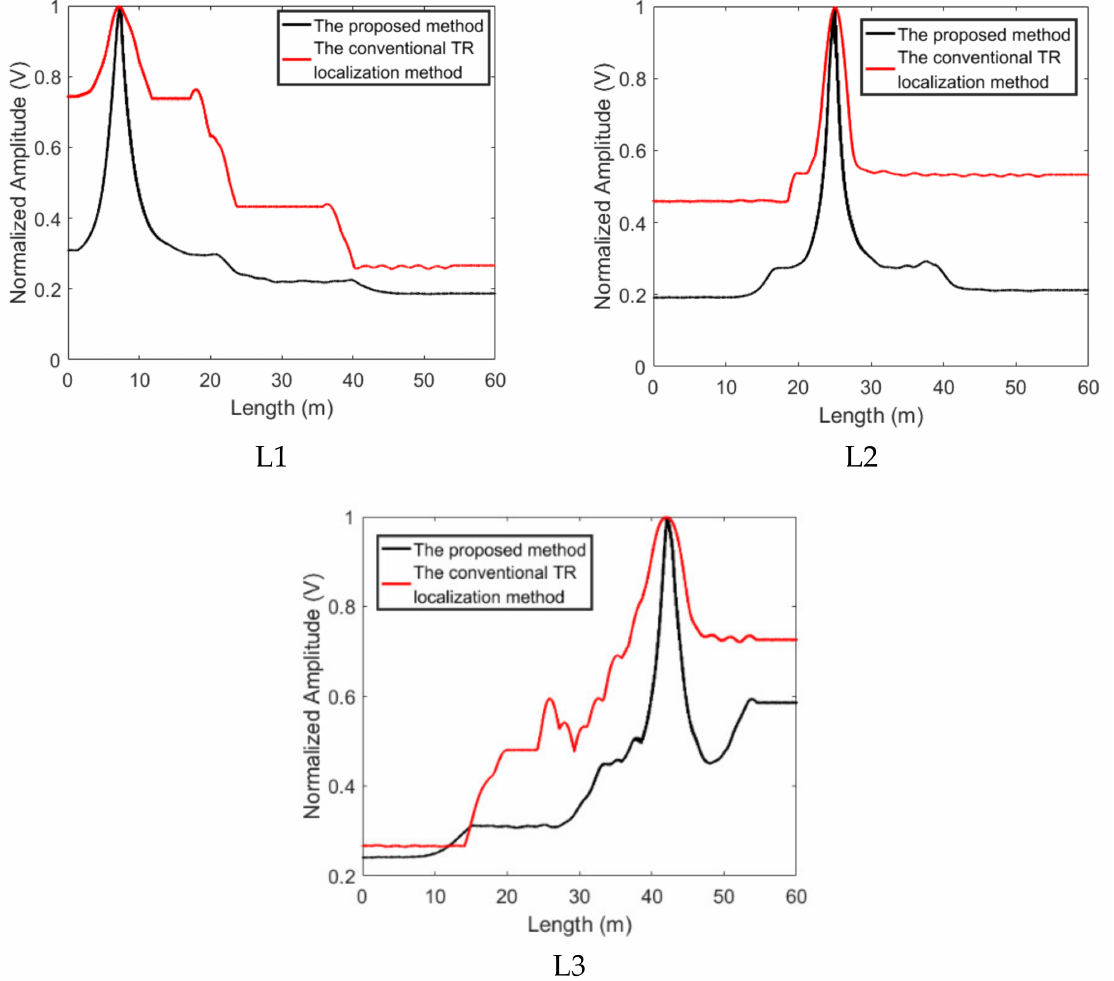
Figure 6. The localization results obtained by using the proposed method and the conventional TR localization method based on the maximum of the time reversed